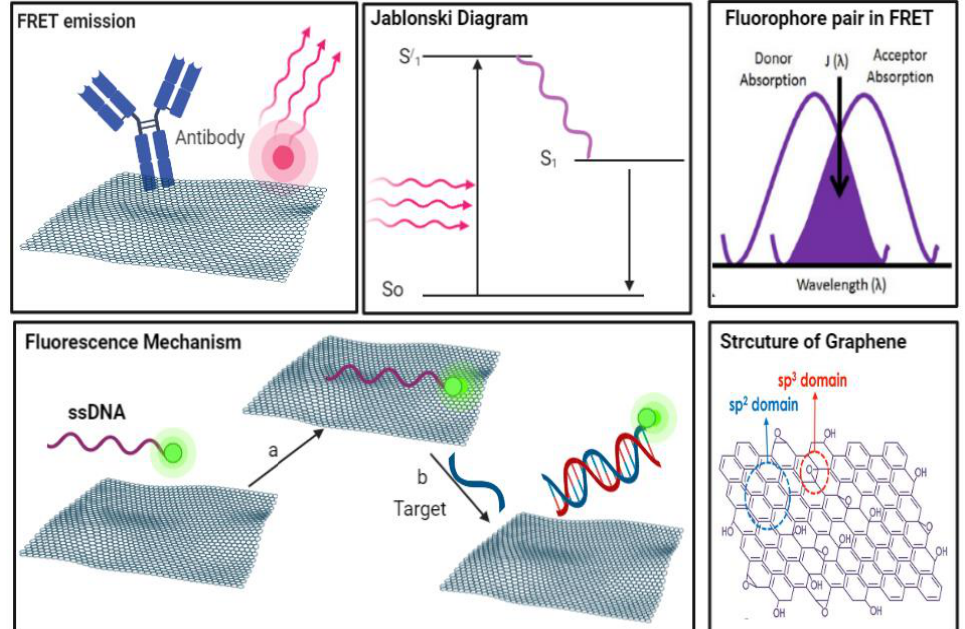
Figure 1. Illustration of the FRET emission mechanism on graphene oxide related to Jablonski dia- gram.